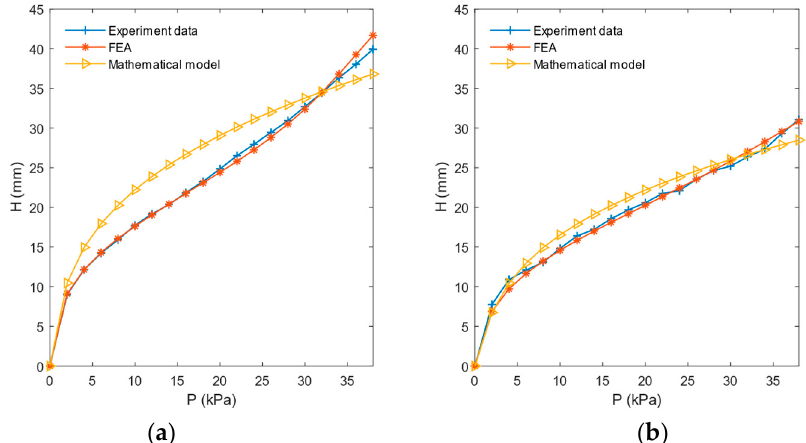
Figure 18. Relationship between CTPM and SAM center point displacement and air pressure. ( a ) Relationship between CTPM center point displacement and air pressure and ( b ) relationship be- tween SAM center point displacement and air pressure. Experimental data represent the relationship between center point displacement measured by the model and air pressure. FEA represents the relationship between center point displacement and air pressure based on the ABAQUS finite-element analysis. Mathematical model, which models data into Equations (5)–(8), represents the relationship between the displacement of the center point and the air pressure.